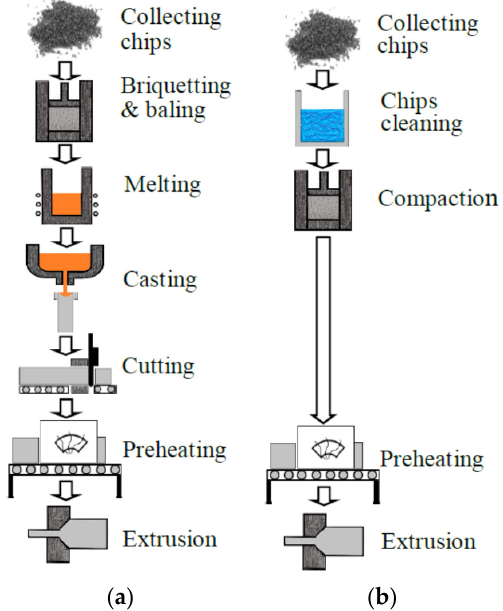
Figure 1. Aluminium recycling technique: ( a ) remelting and refine; ( b ) solid-state recycling.